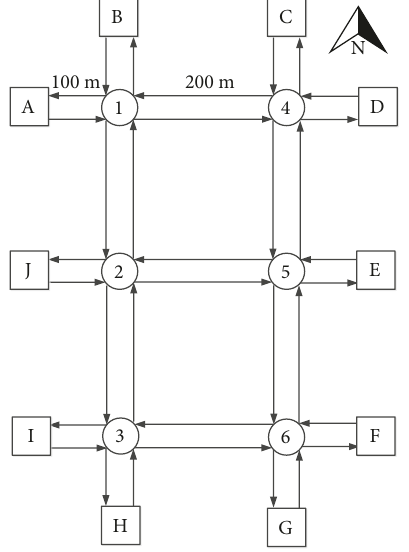
Figure 6: Layout of “toy” network with six intersections. 4.3. Evaluation of Algorithms. The algorithms of the pro- posed model are evaluated with increasing scale of networks.